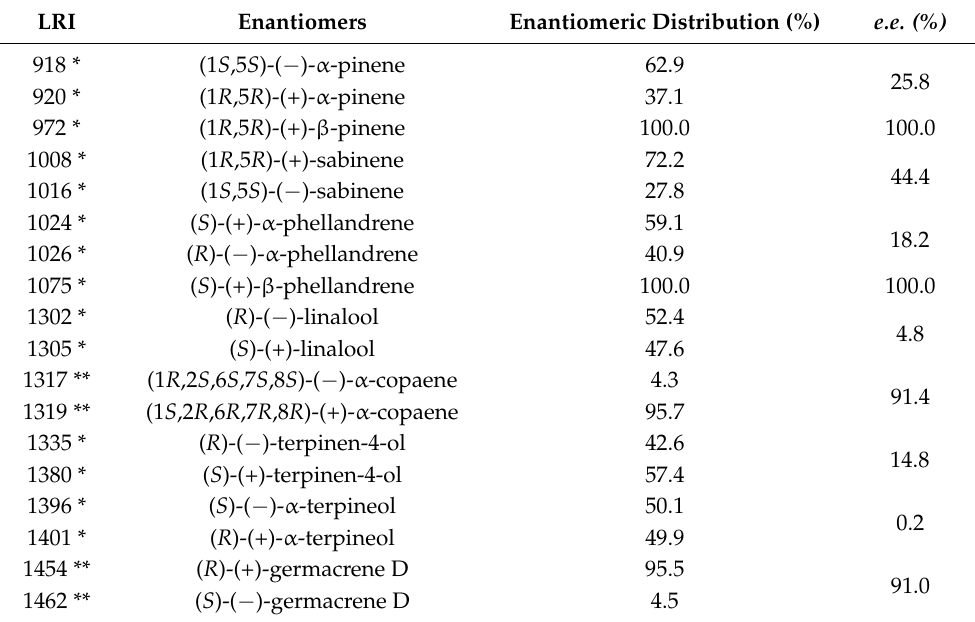
Table 2. Linear retention indices (LRI), enantiomeric distribution (%), and enantiomeric excess ( e.e. ) of some chiral terpenes in G. rugulosa leaves